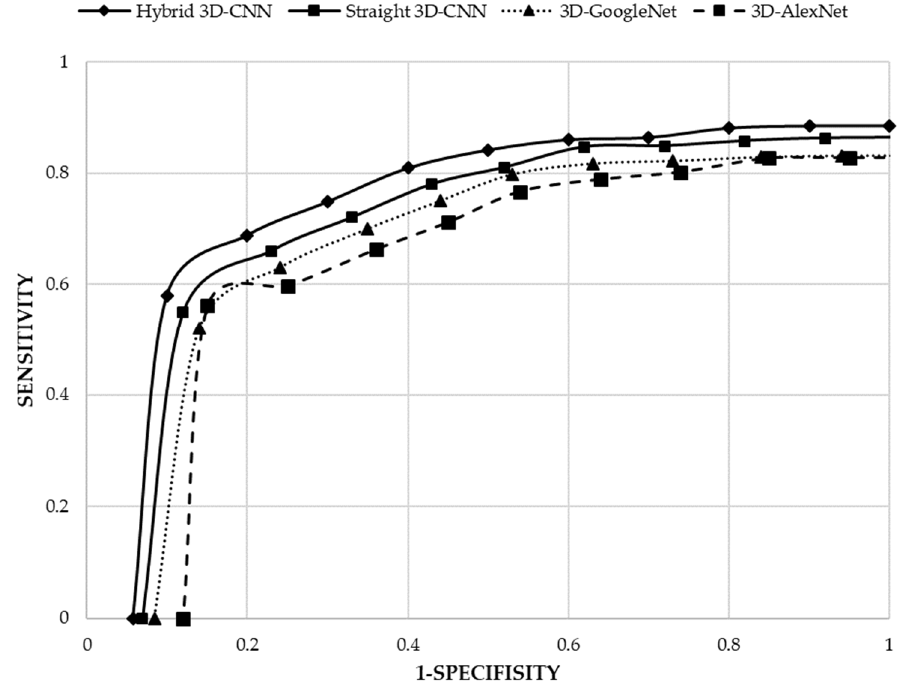
Figure 6. Roc curve of the four 3D-CNN architectures.